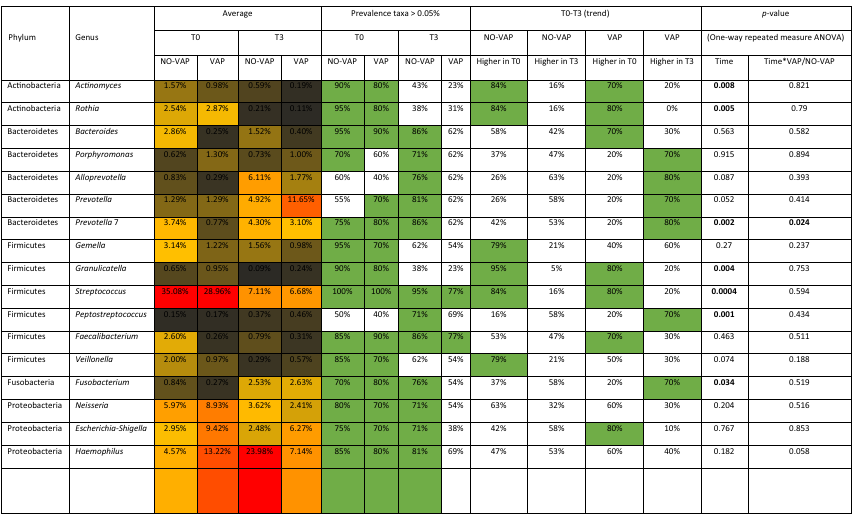
Table 2 Representation of the most prevalent taxa of the study. For each genus, the average relative abundance, the prevalence for each group, and taxonomic trend are reported. Prevalences and trends > 70% are highlighted in